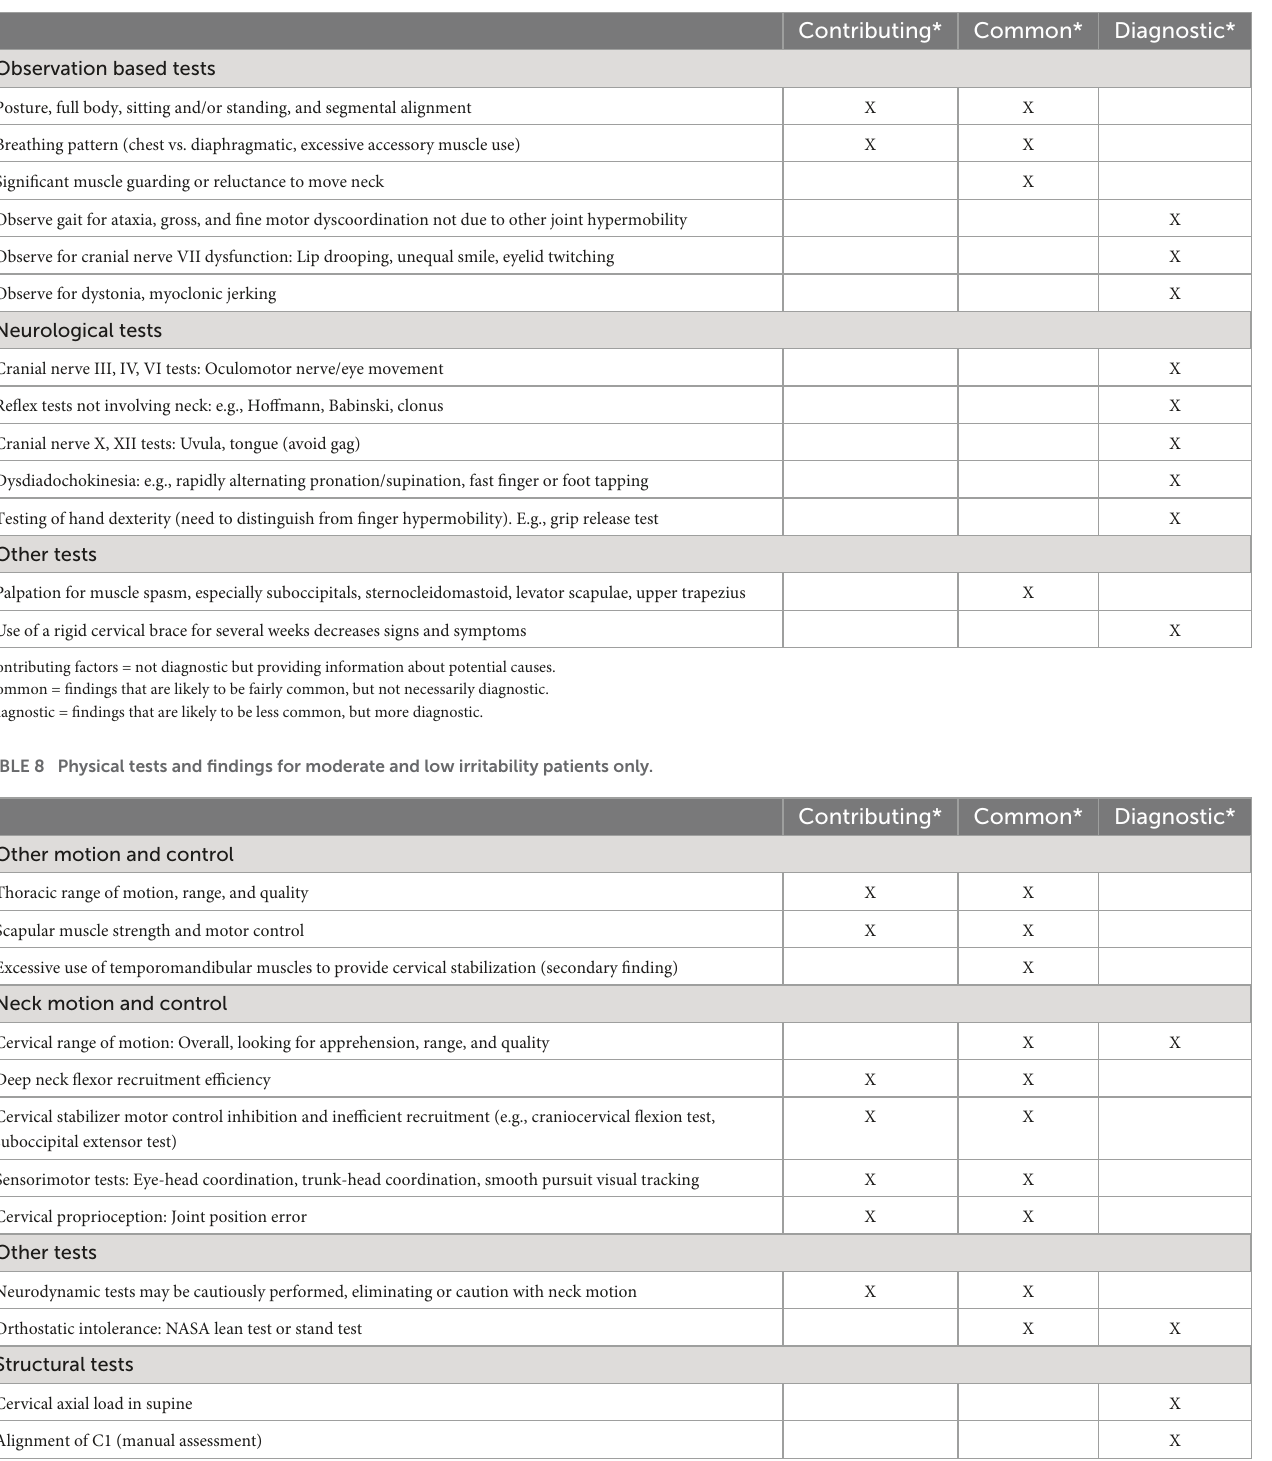
Contributing* Common* Diagnostic*